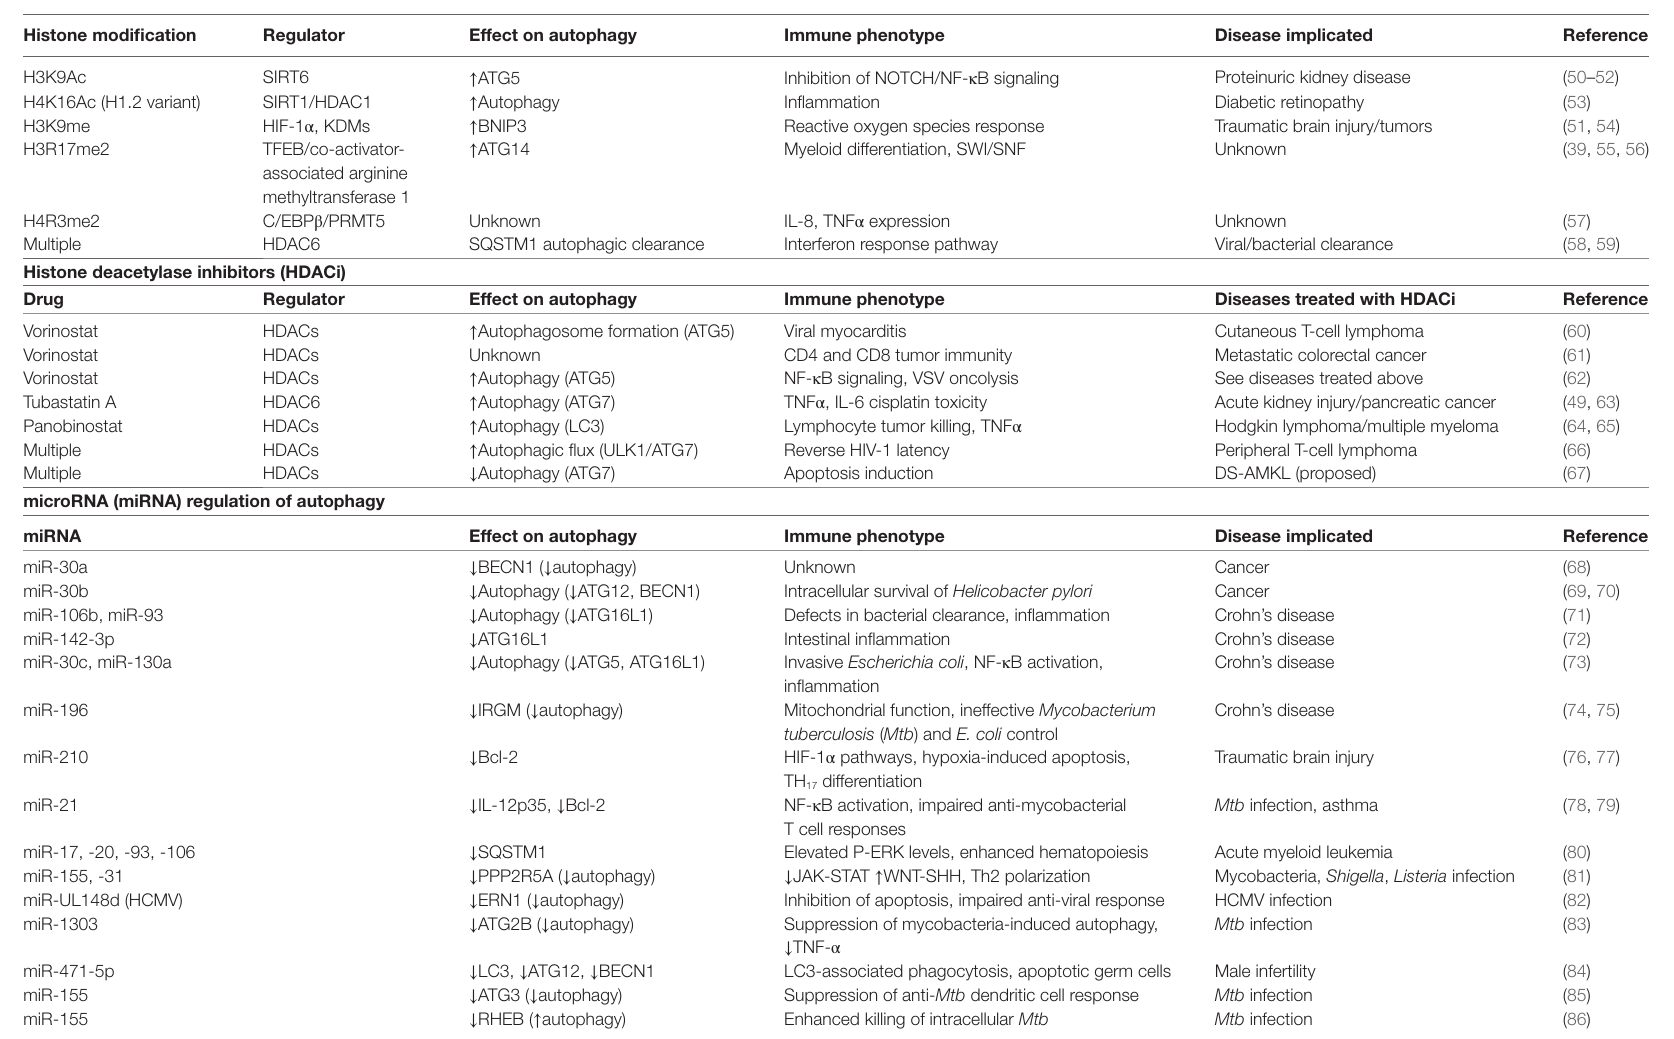
TABLe 1 | Epigenetic regulators associated with autophagy and